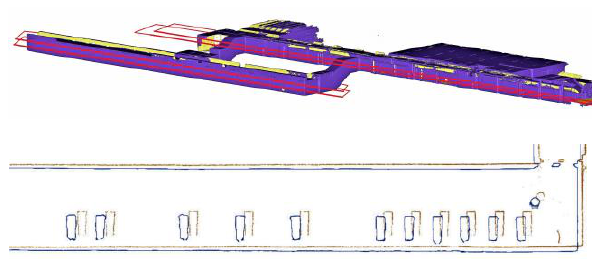
Figure 12. View of horizontal section from BLK2GO and Matterport (with scale distortion) clouds